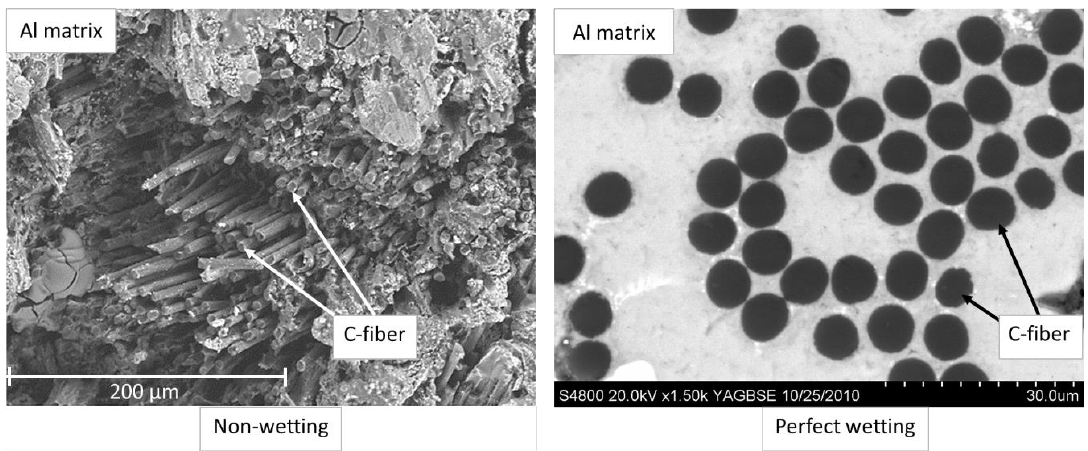
Figure 3. The reinforcement (C-fiber) and the matrix (aluminum) position in the case of a “non-wetting” and a “perfect wetting” system.